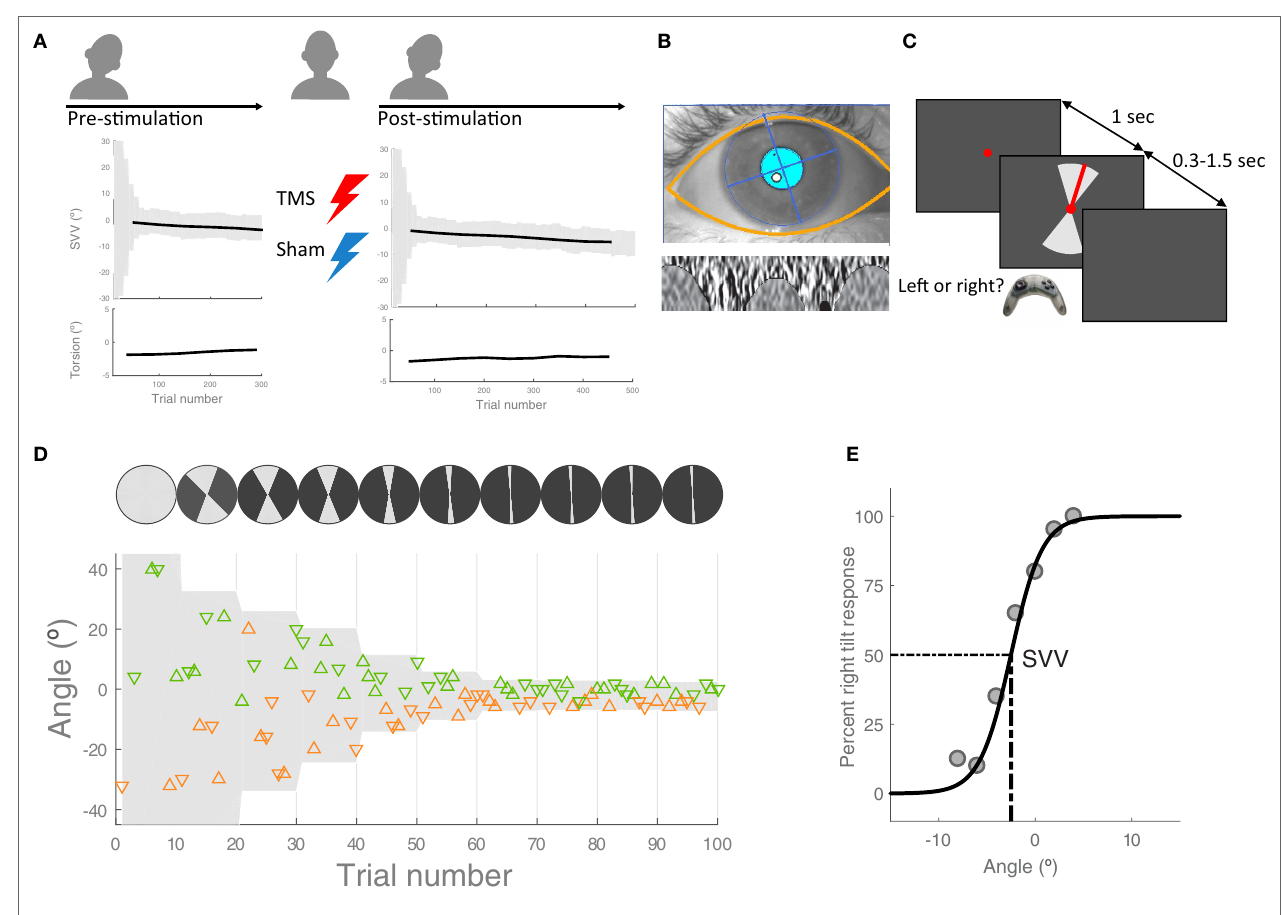
FigUre 1 | Experiment procedures: (a) in each session, first, the head was tilted 20° to the left and 300 subjective visual vertical (SVV) trials were recorded along with ocular torsion as the baseline values before transcranial magnetic stimulation (TMS) or sham stimulation [see (c,D) for details of SVV paradigm]. The head was then brought to upright position in order to apply TMS or sham stimulation. Following each stimulation, the head was tilted again and SVV and ocular torsion were recorded for 500 trials. These pre- and post-stimulation values were used to calculate changes in SVV and ocular torsion. (B) Ocular torsion was measured using iris tracking based on polar transformation of infrared images of the iris. An example eye image captured by this VOG method is shown, with the overlay of automatically detected eyelids and pupil (top) and the extracted iris pattern optimized to calculate ocular torsion (bottom). For more details, see Ref. (16). (c) SVV recording: in each trial, participants fixated on a red dot for 1 s before the line appeared. They had 1.5 s to respond if the line was tilted to the left or to the right of their perceived upright orientation (2-AFC). This was done by pressing the left or right button on a controller. After pressing the button, the line disappeared and the next trial started with a new line orientation. The line was presented within a range of angles (gray shade), which was adjusted every 10 trials. (D) SVV paradigm: a sample of responses for the first 100 trials is shown. The y -axis shows the line angles and each triangle represents one trial. The triangles that point up are the trials when the line was presented in the upper visual hemifield and the triangles that point down are the trials when the line was presented in the lower visual hemifield. The left tilt responses are in orange and the right tilt responses are in green. In order to track SVV changes, the line angles were presented randomly within a range that started at 360° and then adjusted in subsequent blocks (i.e., every 10 trials) based on the responses from previous blocks. (e) Example of SVV calculation: The center of a psychometric function fit was used to calculate SVV values in windows of 100